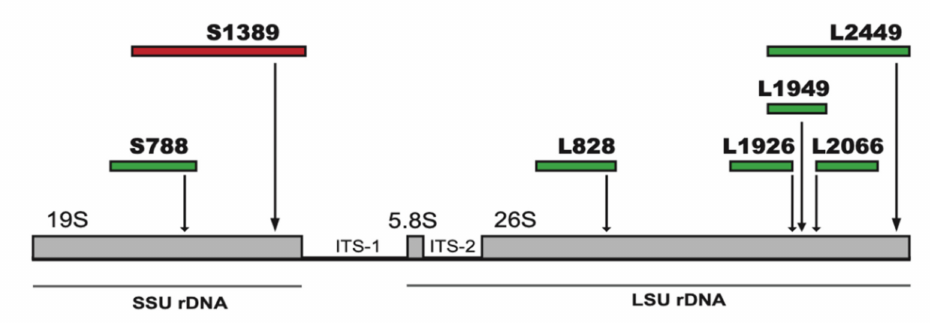
Figure 1. Schematic representation of nuclear rDNA of Mucilago crustacea. The SSU rDNA (19S rRNA gene region) is interrupted by group I introns at positions S788 and S1389. The LSU rDNA (5.8S + 26S rRNA gene regions) is interrupted by five group I introns at positions L828, L1926, L1949, L2066, and L2449. See GenBank accession number MZ313554 for details.